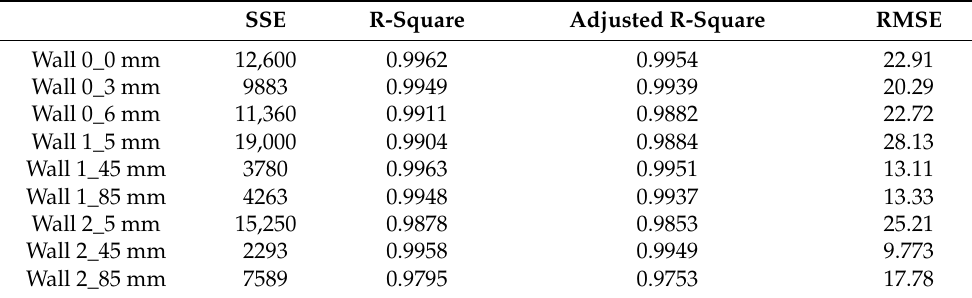
Table 5. The goodness of fit results. SSE